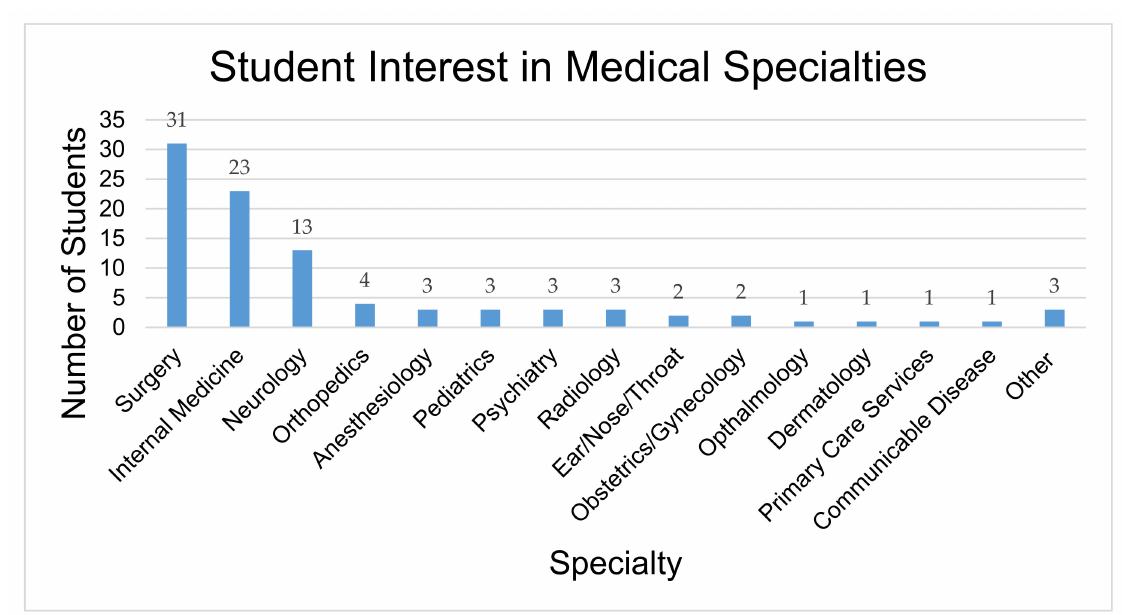
Figure 2. Second- and third-year medical students expressed interest in specific medical specialties ( n = 94). Answers were selected from a multiple-choice question of common specialties offered in Nepali medical